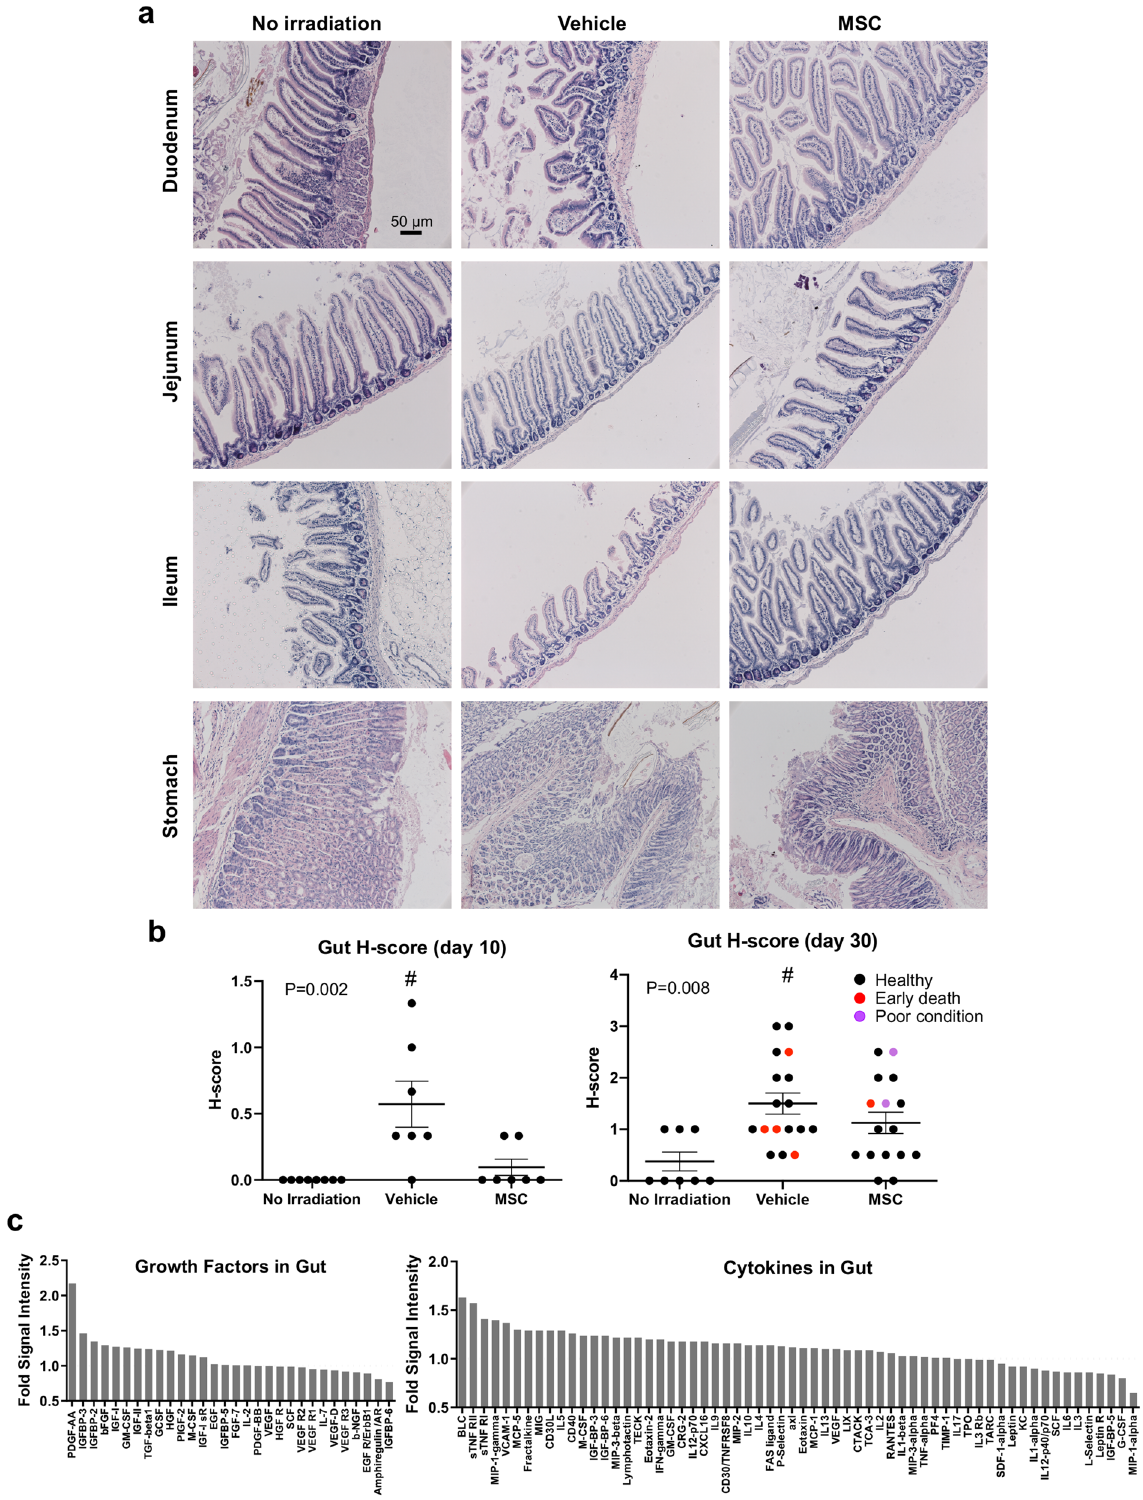
Figure 7. Small intestine exhibits signs of injury. ( a ) Photomicrographs of the small intestine show pathology of the mucosa. ( b ) H-scores of histopathological analysis of the gut at day 10 and the terminal time point are consistent with greater injury to the small intestine in vehicle treated mice that is less evident in recipients of MSC therapy (Kruskal–Wallis One Way Analysis of Variance on Ranks, Dunn’s Method # P < 0.05 for No irradiation vs. Vehicle). ( c ) Cytokines and growth factors in the gut are altered by MSC